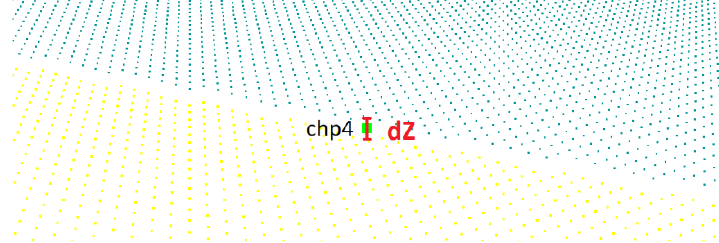
Figure 9. Magnification of the aperture dZ between two segments.